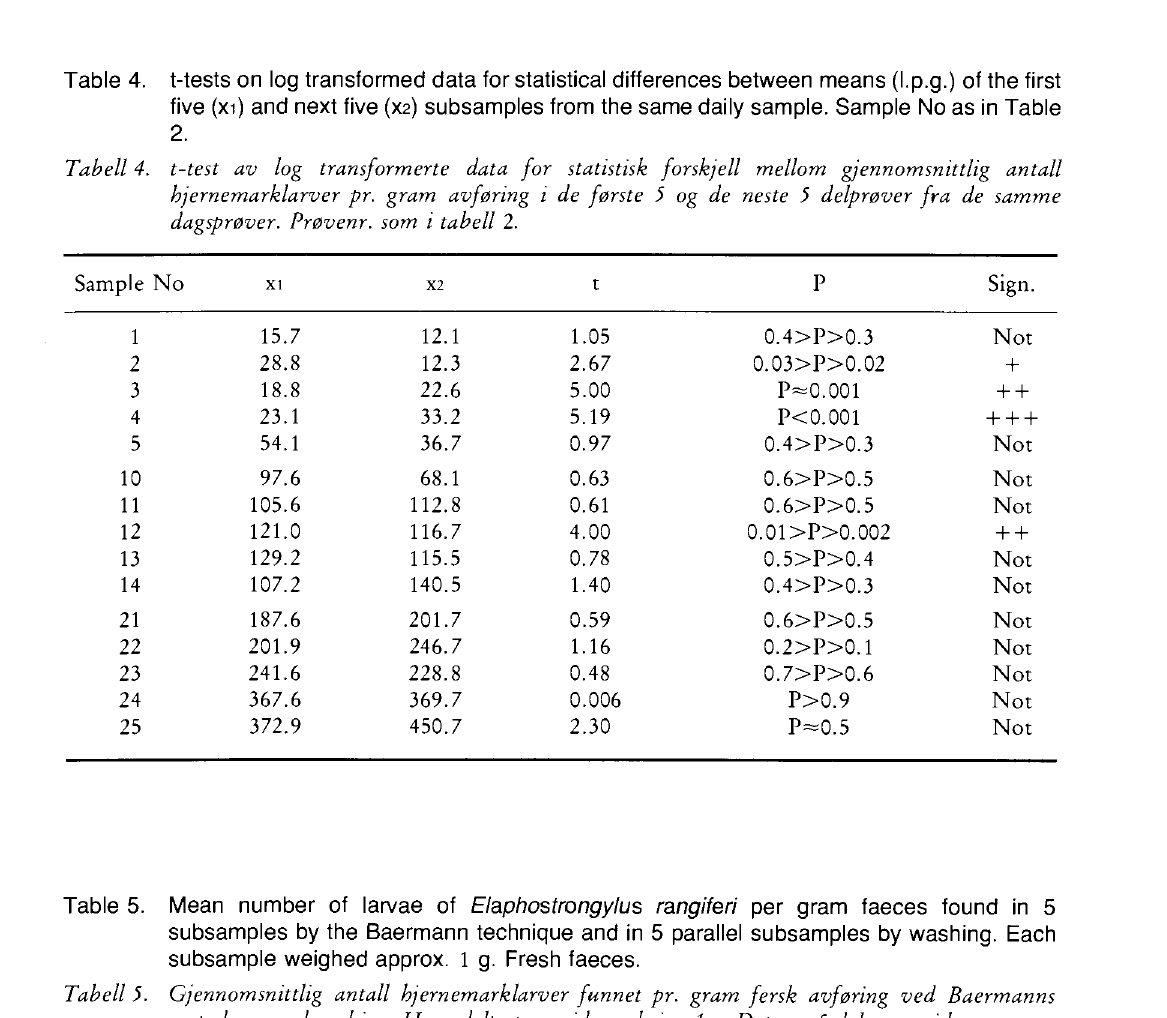
Mean number of larvae of Elaphostrongylus rangiferi per gram faeces found in 5 subsamples by the Baermann technique and in 5 parallel subsamples by washing. Each subsample weighed approx. 1 g. Fresh faeces. Tabell J.